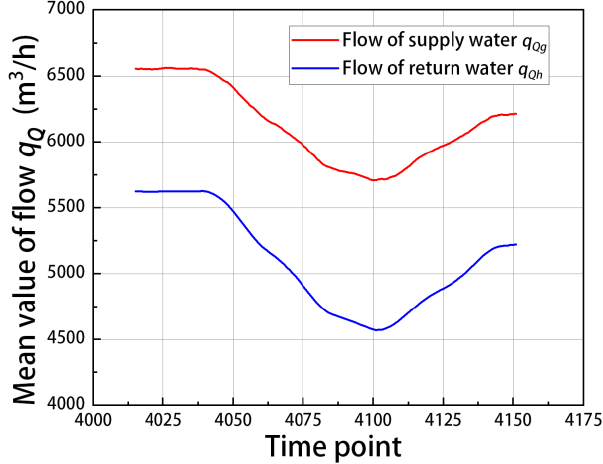
Figure 7. Average value of the flow data.